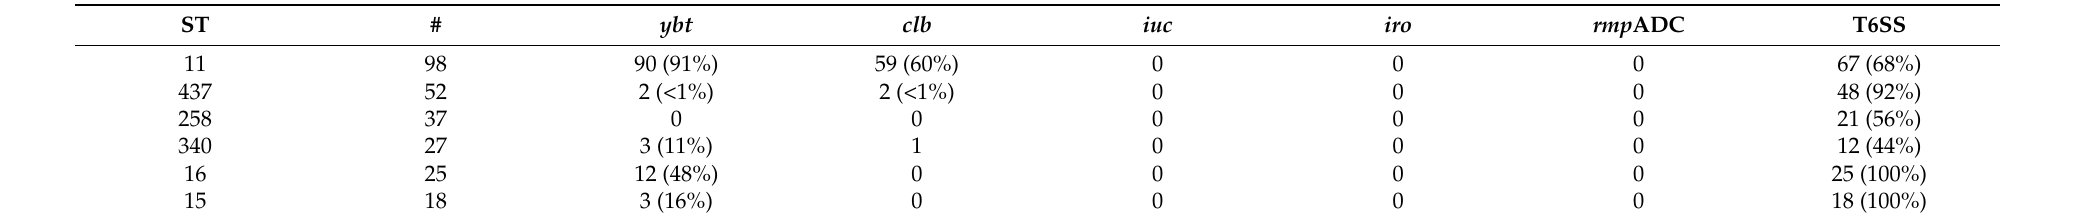
Table 4. Prevalence of virulence loci in the main STs of Klebsiella pneumoniae in